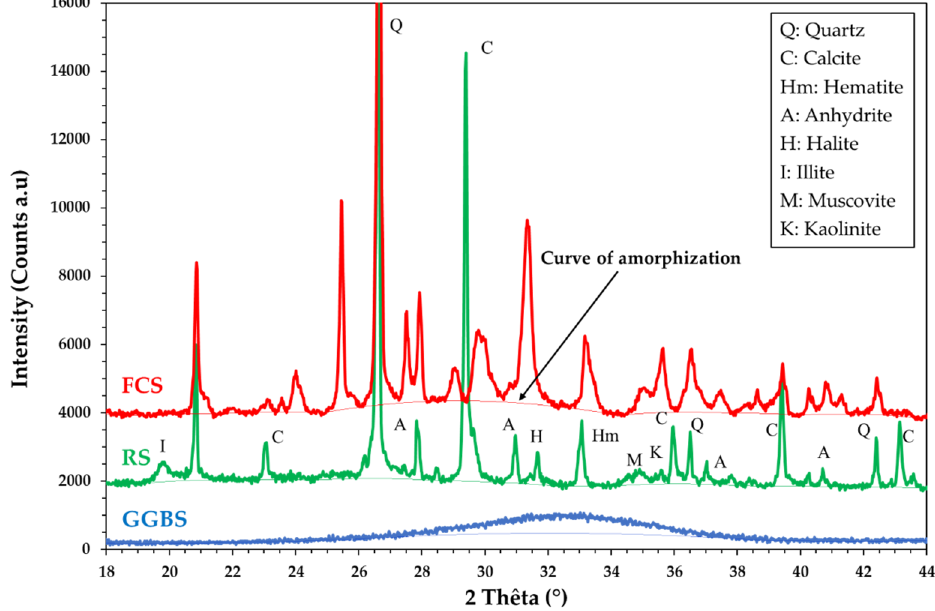
Figure 2. XRD pattern of ground granulated blast furnace slag (GGBS), raw sediment (RS), and flash-calcined sediment (FCS) . flash-calcined sediment